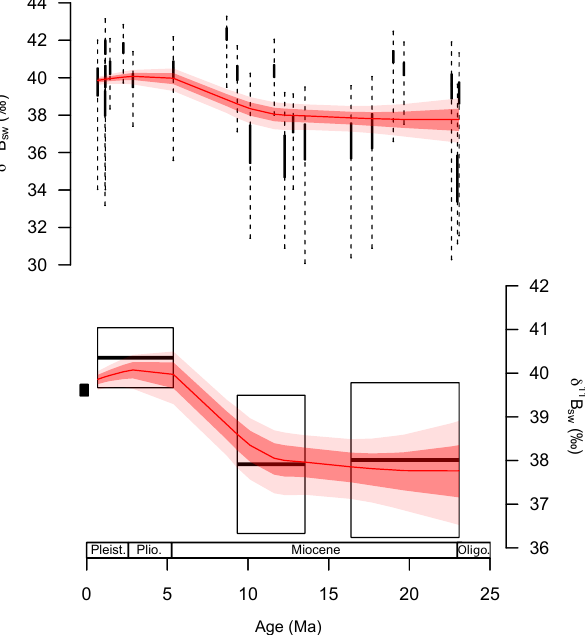
Figure 10. The calculated δ 11 B sw from the benthic–planktic δ 11 B pairs using a pH gradient derived from δ 13 C . The uncertainty on each data point is determined using a Monte Carlo approach, in- cluding uncertainties in temperature, salinity, δ 11 B and pH gradient (see text for details). Data are plotted as box and whisker diagrams where the median and interquartile ranges as plotted in the box and whiskers show the maximum and minimum output from the Monte Carlo simulations. The line of best fit is the probability maximum of a LOWESS fit given the uncertainty in the calculated δ 11 B sw . The darker shaded area highlights the 68% confidence interval and the lighter interval highlights the 95% confidence interval. The bot- tom panel shows box plots of the mean and 2 standard error (SE) of “binning” the individual δ 11 B sw measurements into 8My inter- vals. The middle line is the mean and the box shows the 2SE of the data points in that bin. The smoothed record is also plotted for comparison where the line of best fit is the probability maximum of a LOWESS fit given the uncertainty in the calculated δ 11 B sw . The darker shaded area highlights the 68% confidence interval and the lighter interval highlights the 95% confidence interval. The black dot is the modern value of 39.61‰ (Foster et al.,